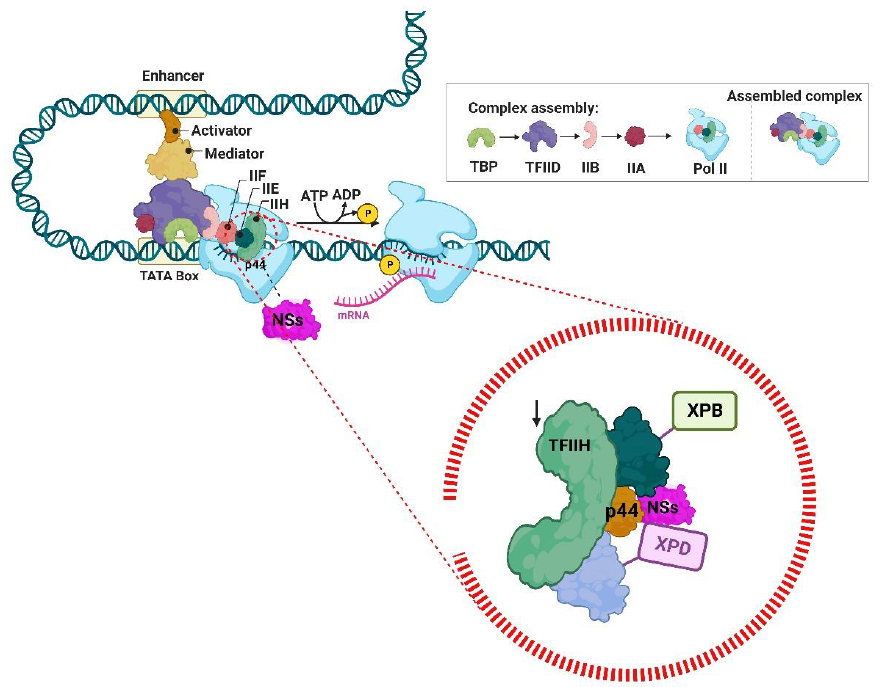
Figure 7. Schematics of RVFV NSs-mediated TFIIH suppression. The top portion illustrates the transcription factor of the RNA. At the same time, NSs protein (pink) binds to p44 and XPB, inhibiting TFIIH subunits assembly and the formation of the complex to evade host response and shut off host transcription. Created with BioRender.com (Accessed on 14 September 2022).